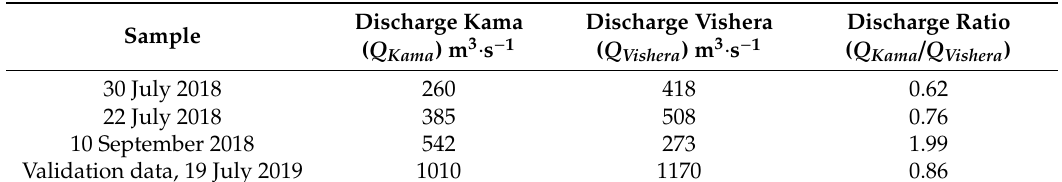
Table 1. Discharge ratios sampled in this study.